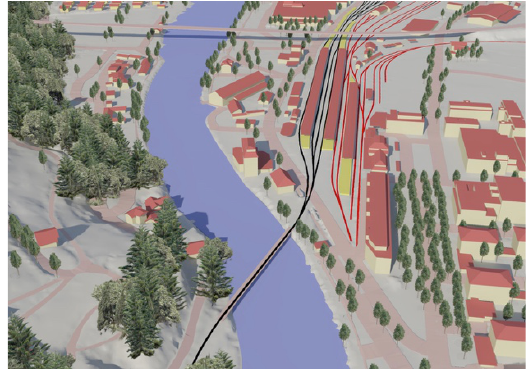
Figure 10 Representation of swissTLM3D elements near the City of